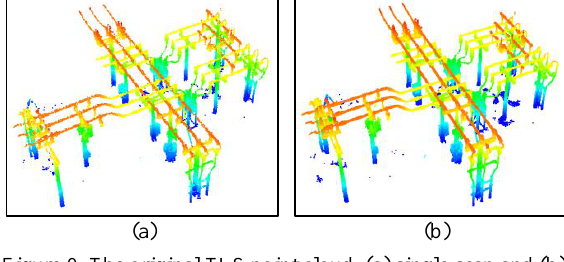
Figure 9. The original TLS point cloud: (a) single scan and (b)